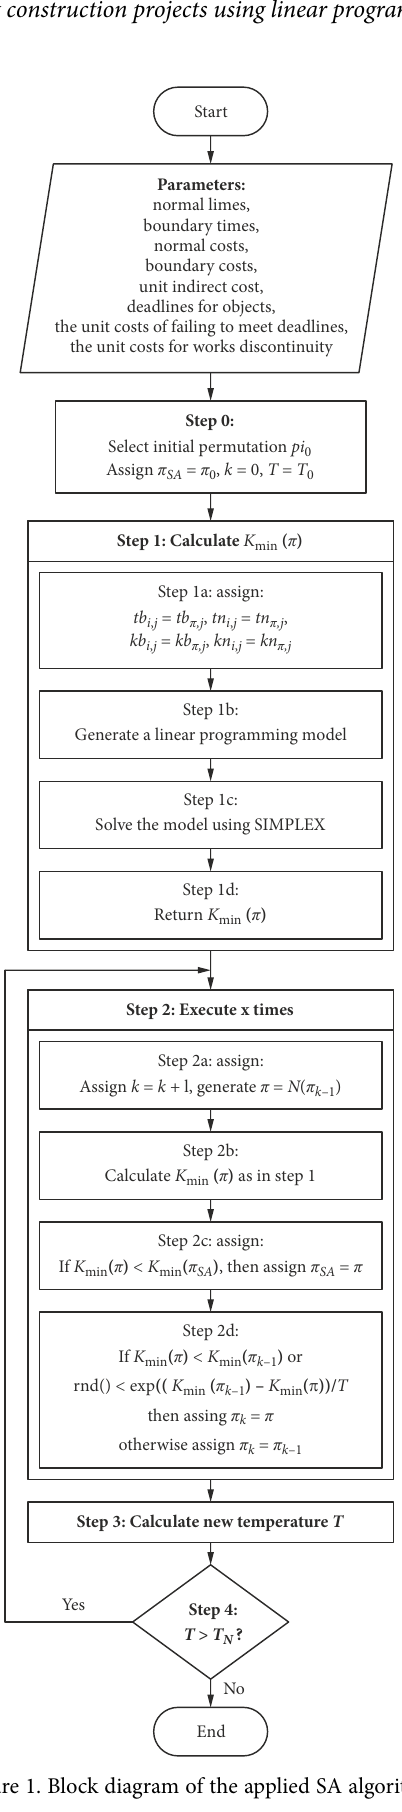
Figure 1. Block diagram of the applied SA